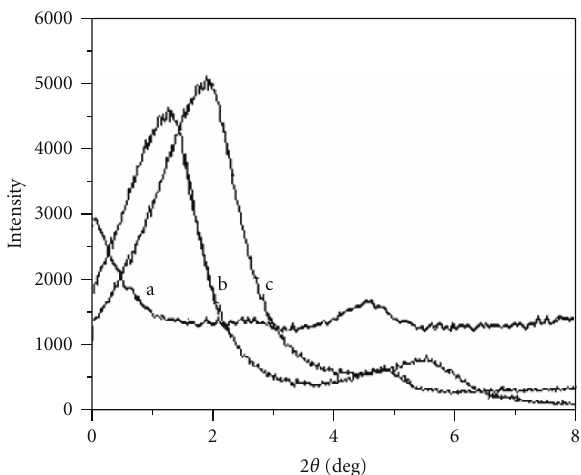
Figure 2: XRD of PAN/MMT nanocomposites(a)5%, (b) 10%w/v, and (c) pure MMT